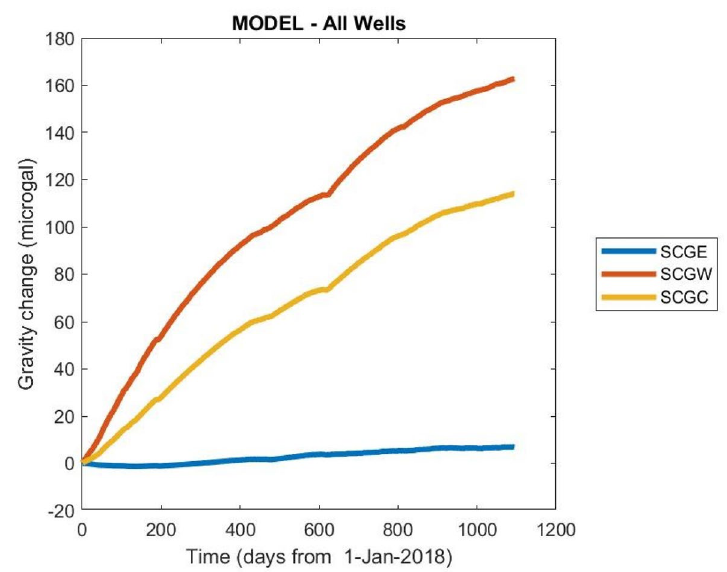
Fig. 10 Gravity modelled for the three gravity stations considering masses extracted/injected from all wells. Although the mass balance is close to zero in the modelling, gravity increases as the injected mass is located closer to the surface, explaining that the modelled total contribution is positive at all three